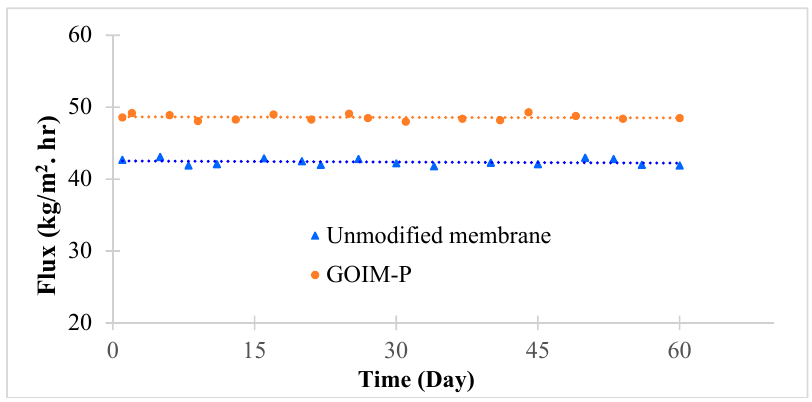
Figure 8. Stability of the membranes at a 70 °C feed temperature and 10,000 ppm of NaCl solution.